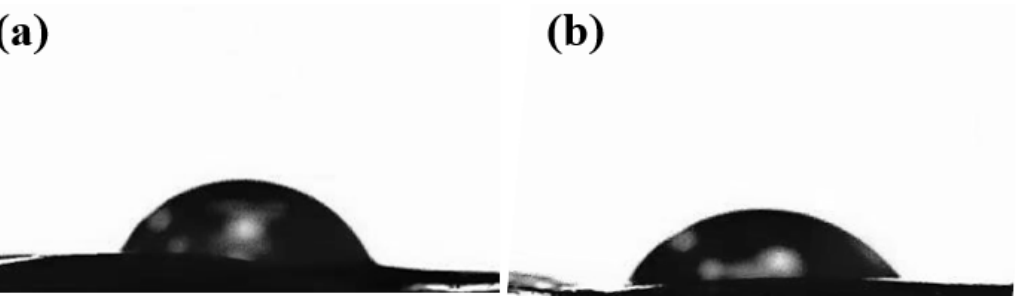
Figure 5. Static contact angle of ( a ) HNM ‐ 1 and ( b ) HNM ‐ 4 is 65.49° and 51.96°, respectively.